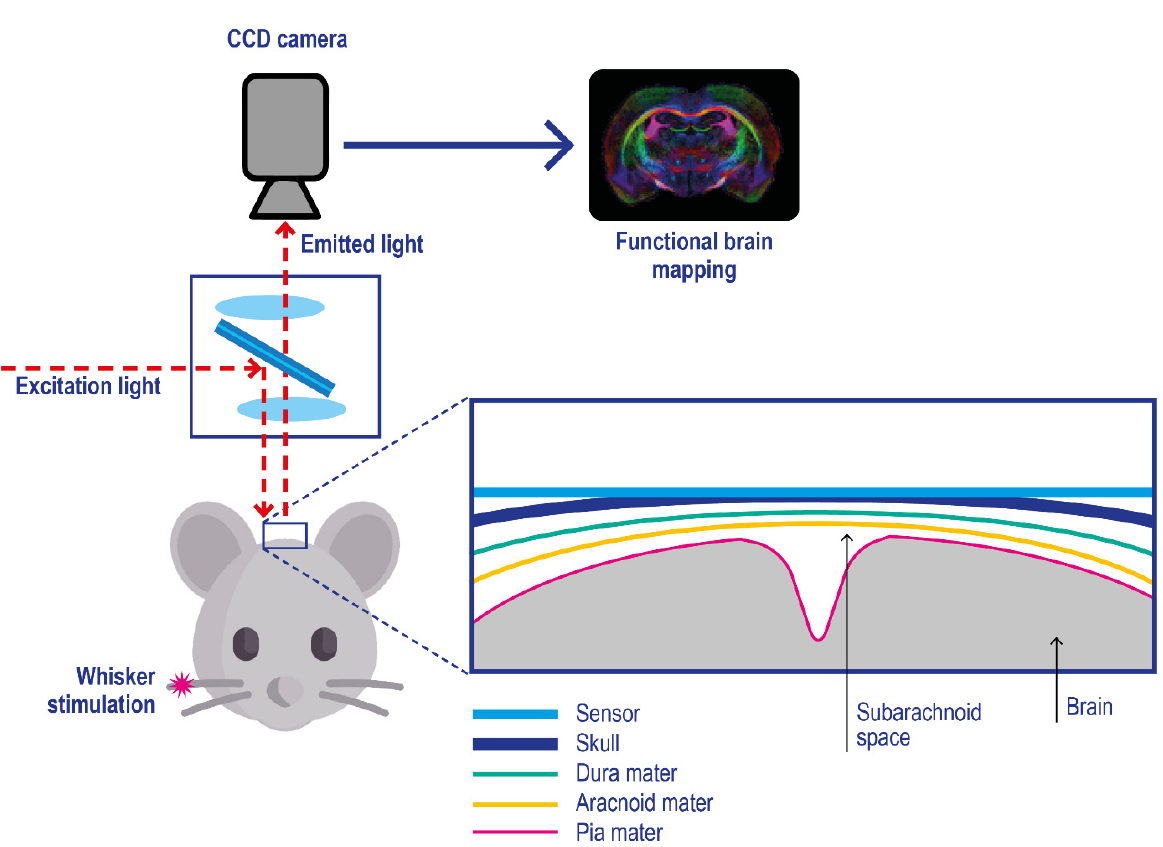
Figure 7. Experimental setup for in vivo optical imaging of oxygen metabolism in brain tissues using a planar phosphorescence PtBP-based oxygen sensor. Pink asterisk: physical stimulation of the rat whisker. The skull cortex of the mouse is illuminated with light at 630 nm, and the emitted photons with a wavelength above 690 nm are acquired with a CCD camera. Adapted with permission from [123].